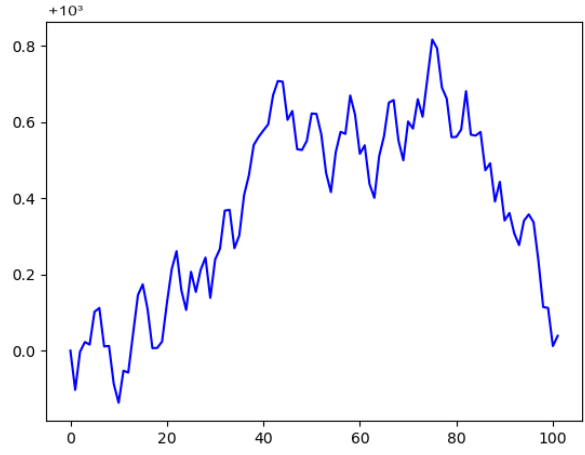
Figure 2. An exemplary margin chart from a test run on EURUSD in 45 s.